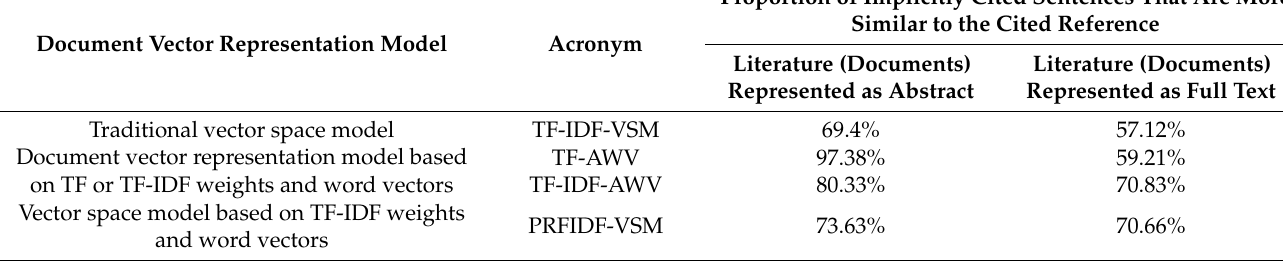
Table 4. Implicit citation sentences based on various document vector representation models with the cited/ reference similarity comparison